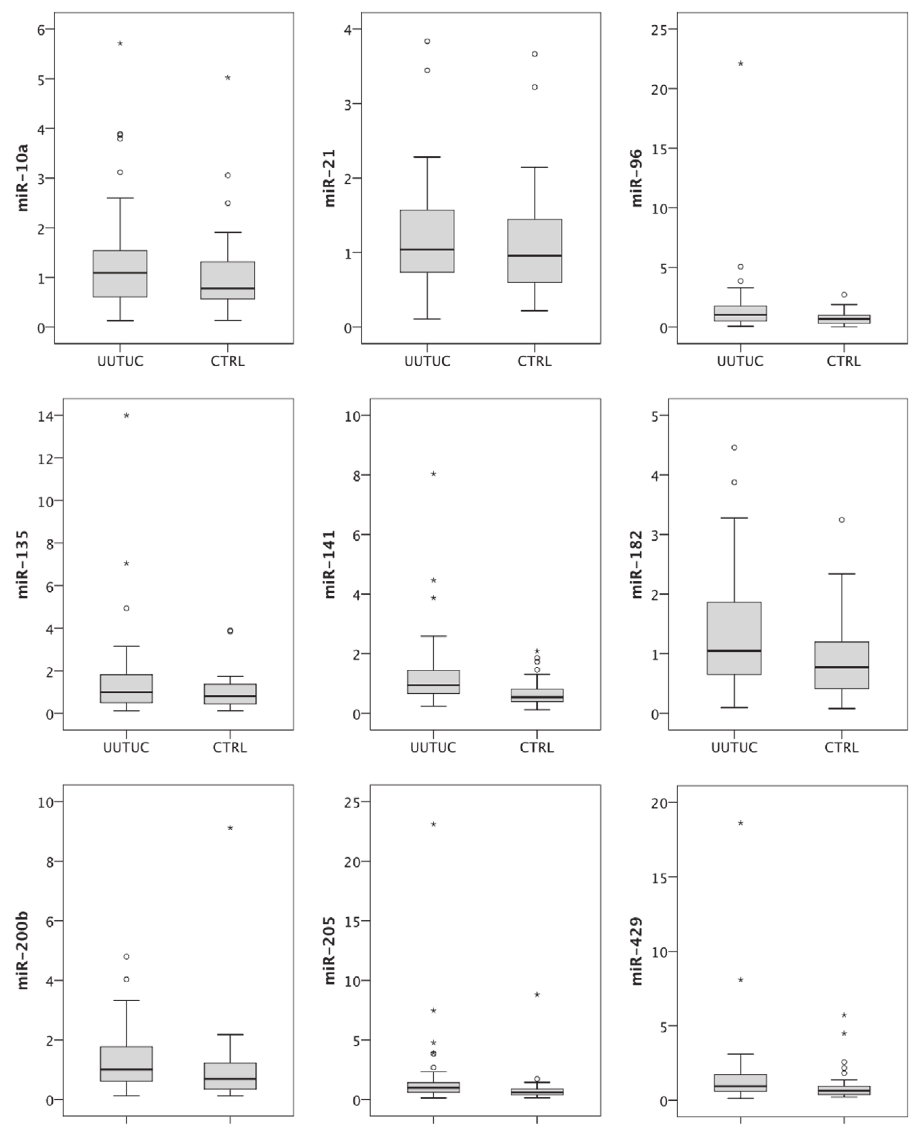
Fig 2. Serum microRNA levels are increased in patients with upper urinary tract urothelial carcinoma compared to patients with non-malignant disease. The Mann-Whitney-U test was used to evaluate differences between the